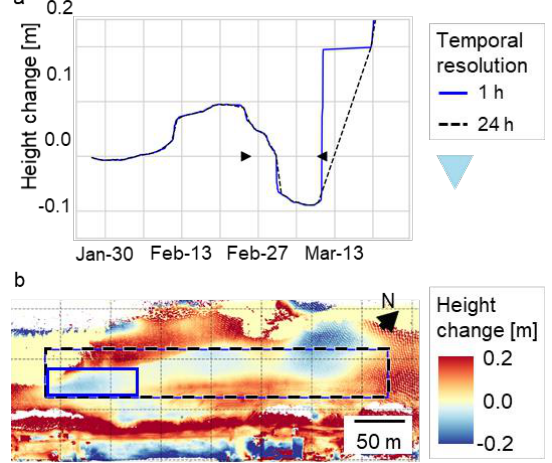
Figure 9. Results for an example 4D object-by-change using the reference and a reduced temporal resolution of 24 h. The change period is marked by arrow heads in the time series of height changes at the seed location (a). The height change map (b) shows the bounding boxes of the delineated change form at the two temporal resolutions. An extreme increase in spatial extent (715 %) occurs at reduced resolution, as the change history of the detected change is not represented completely in Figure 10. Relation of reduced spatial resolution to deviations the lower-resolution time series. The blue triangle below in spatial extent compared to the reference objects obtained at subfigure b depicts the marker used for the object in other highest input data resolutions (1 h and 0.5 m). 4D objects-by- figures. change are separated into three groups of similar scales and deviation behaviour (a-c) for illustration purposes. Note that the scales of y-axes are logarithmic, and only linear between -1 % and +1 %. Distinct colours and markers designate individual objects, which are shown by their properties in Figure 8d.